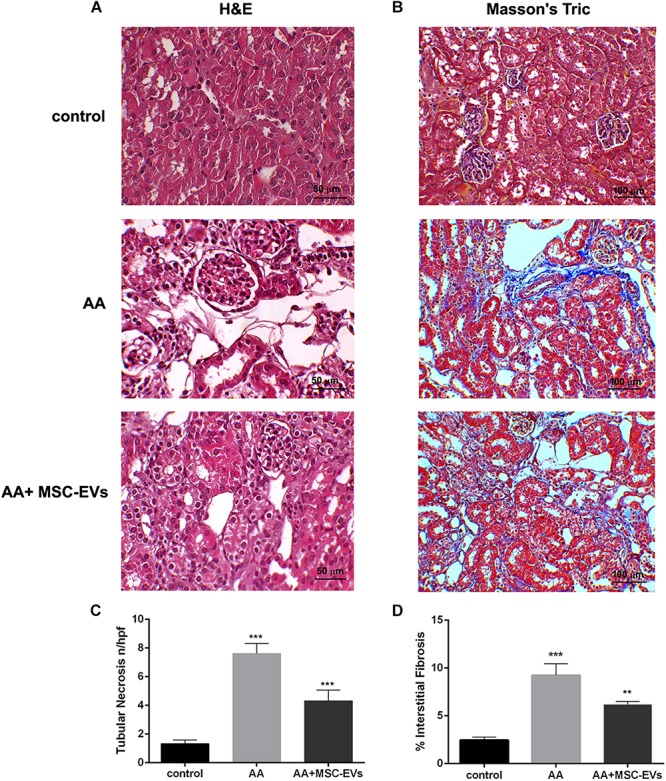
Histological analyses of AAN in vivo model. (A) Micrographs representing H&E stained renal tissue from healthy mice injected with the vehicle alone (control), or mice injected with AA, or AA mice treated with MSC−EVs. Original magnification at 400X. (B) Micrographs representing Masson’s trichrome stained renal sections from control, AA or MSC-EV treated AA mice. The blue stain is collagen fibres signifying interstitial fibrosis. Original magnification at 200X. (C) Histological score of tubular necrosis in AAN mice experimental groups. Mice treated with AA had significantly high levels of tubular necrosis, which was reduced, on treatment with MSC-EVs. Data represent mean ± SEM of tubular necrosis observed under high power field (original magnification: 400X). A one way ANOVA with Bonferroni’s multi comparison test was performed. ***p < 0.001 AA vs. control or AA+MSC−EVs vs. AA. (D) Histological quantification of interstitial fibrosis in AAN mice experimental groups by multiphase image analysis of 10 fields per section. Data represent mean ± SEM; A one way ANOVA with Bonferroni’s multi comparison test was performed. ***p < 0.001 AA vs. control, **p < 0.01 MSC−EV vs. AA.